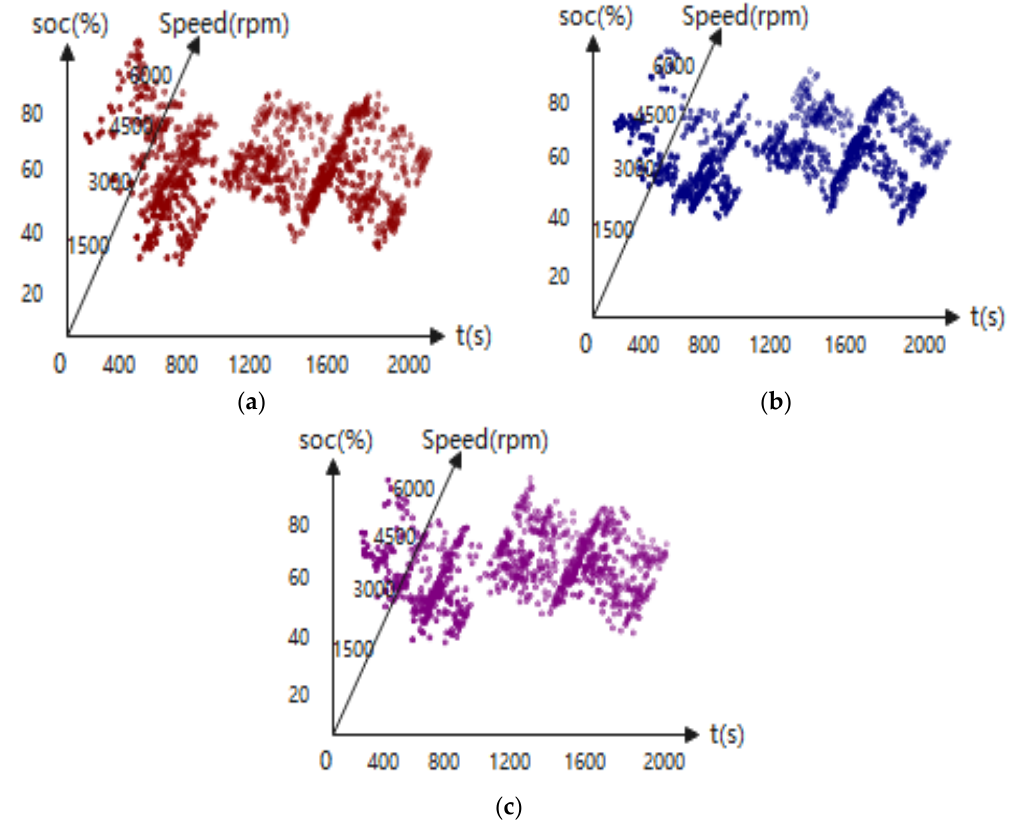
Figure 15. State space distribution of short flight mission: ( a ) S2; ( b ) S1; ( c ) optimal.